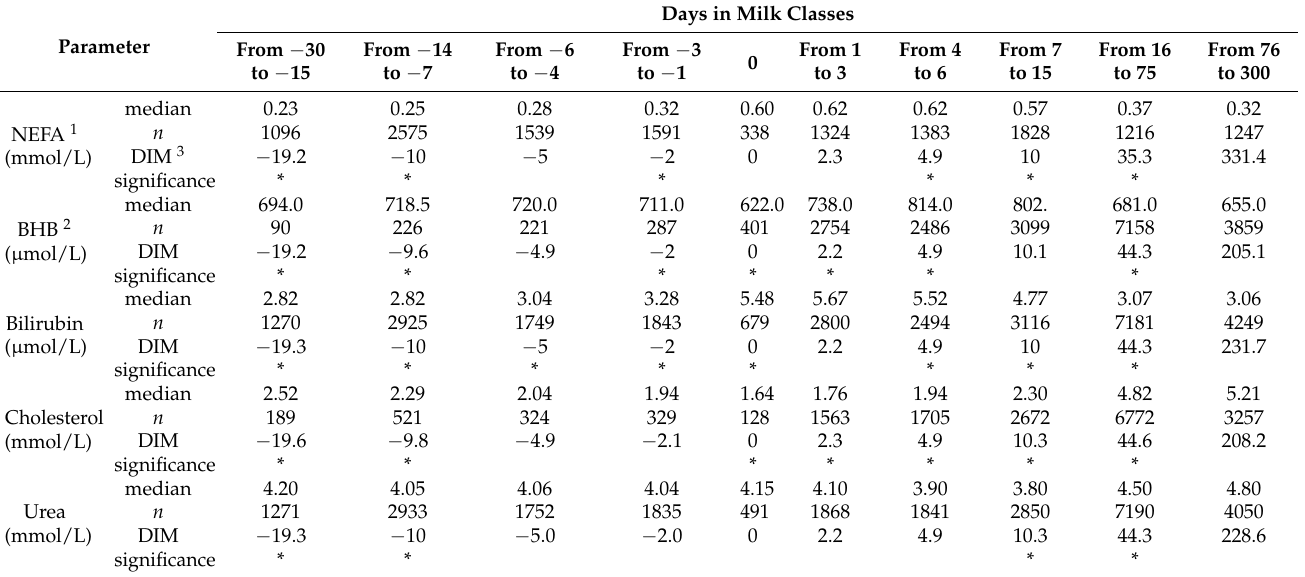
Table A2. Serum parameters of energy and protein metabolism in ten DIM classes in multi- parous